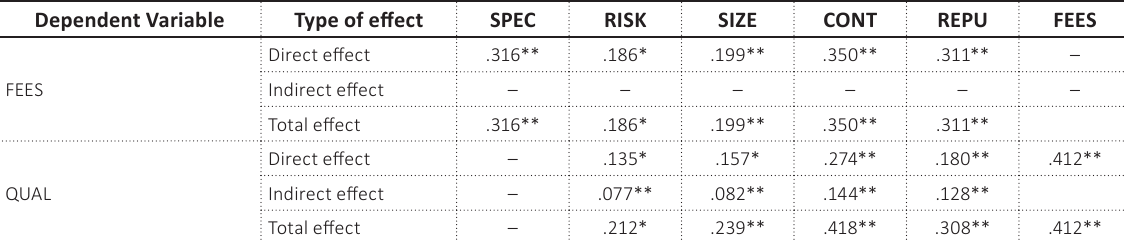
Table 5. Effect decomposition summary